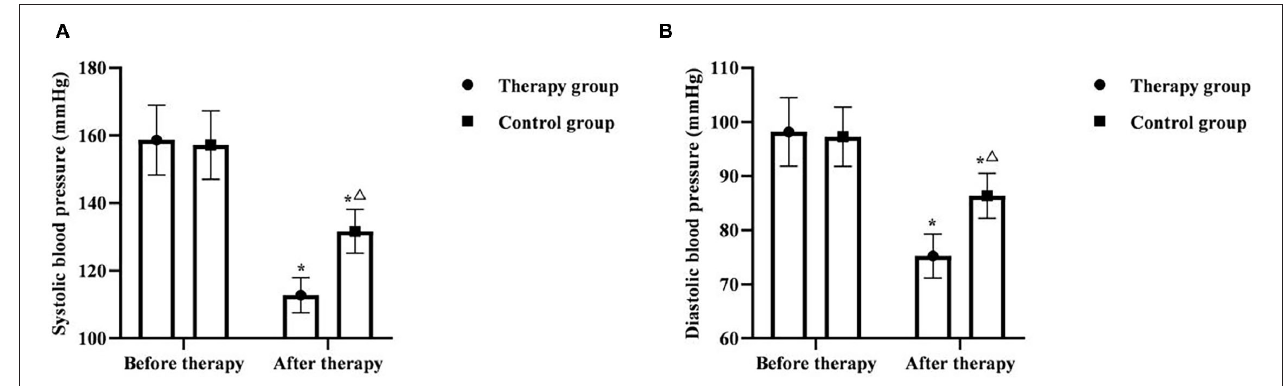
FIGURE 1 | Comparison of blood pressure levels between the two groups ( x ± s , n = 55). (A) was comparison of systolic blood pressure between the two groups. (B) was comparison of diastolic blood pressure between the two groups. * P < 0.05 was compared with the same group before therapy, 1 P < 0.05 was compared with the control group after therapy.